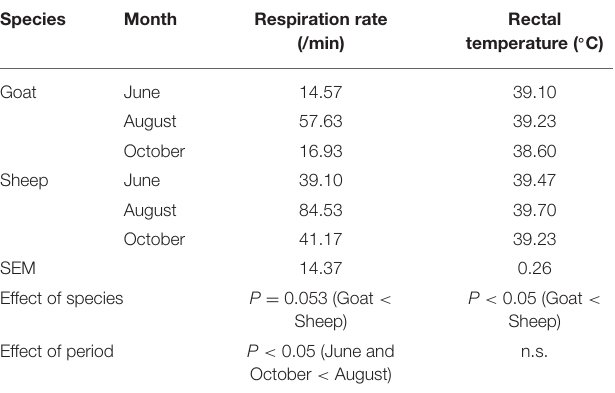
TABLE 3 | Respiration rates and rectal temperatures of the tested